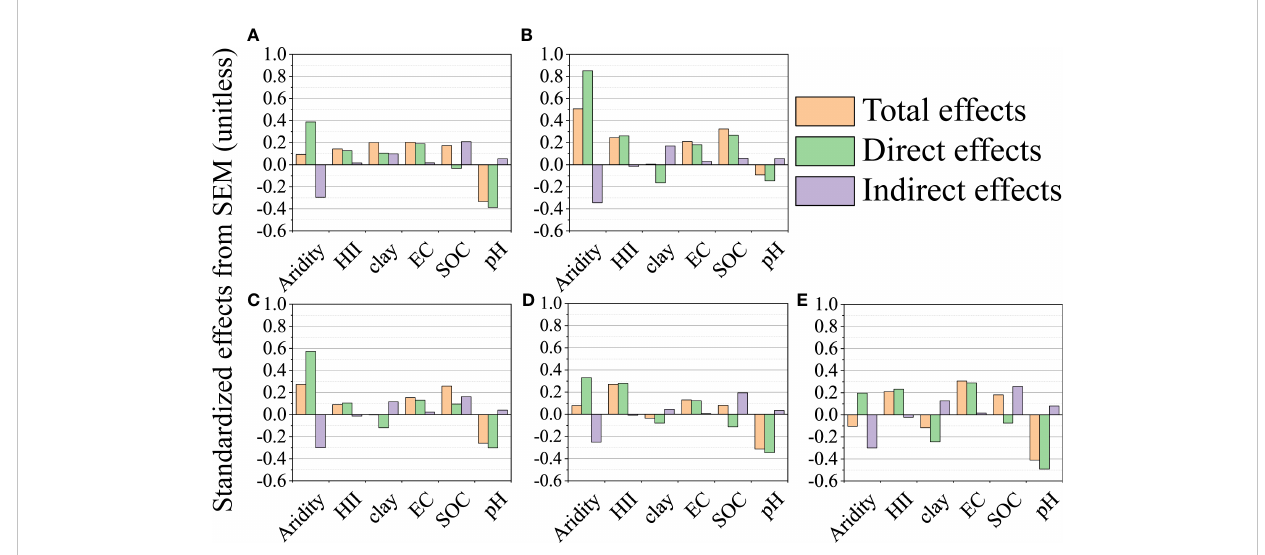
FIGURE 4 Total, direct and indirect effects based on the structural equation model (SEM) for the concentrations of leaf Mn (A) , Fe (B) , Ni (C) , Cu (D) and Zn (E) . Standardized total effects (direct plus indirect effects), and direct and indirect effects of aridity, human impact index (HII), soil clay content, pH, electrical conductivity (EC) and organic carbon (SOC) on the concentrations of leaf Mn, Fe, Ni, Cu and Zn. The yellow column is the total effect, the green column is the direct effect, and the purple column is the indirect